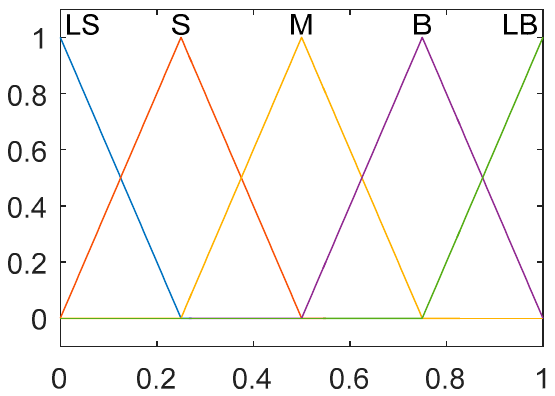
Figure 2. Membership functions for inputs.